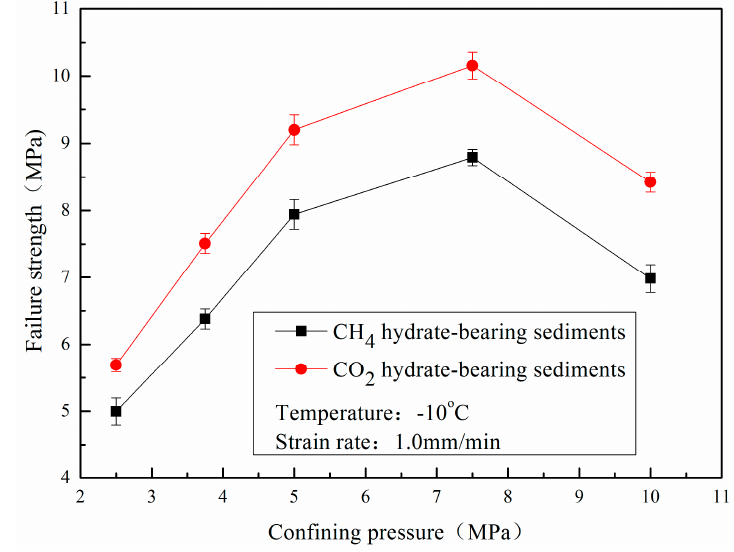
Figure 9. Failure strength of the CH 4 and CO 2 hydrate-bearing sediments under different confining pressures.